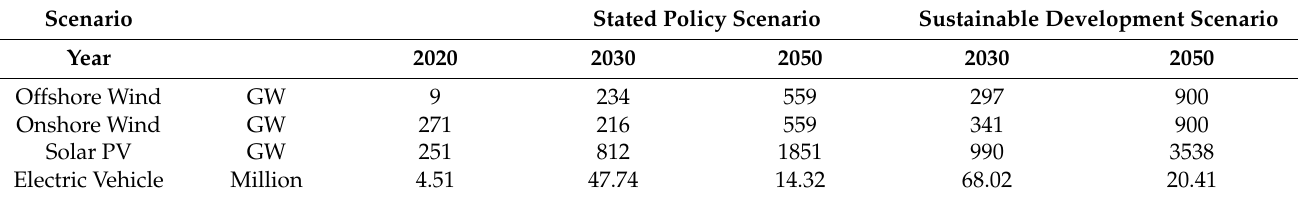
Table 7. New installed capacity of clean energy power generation technology and electric vehicle stock in China (Data Source: [34]).